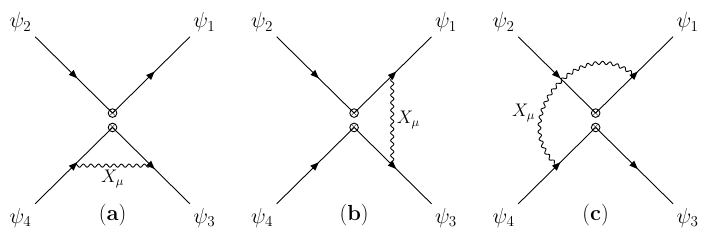
Figure 1 . Current-current topologies with four-fermion insertions. Here X µ represents the gauge bosons B , W and G . The fermion fields q, u, d, ‘, e and n are represented by ψ µ µ µ